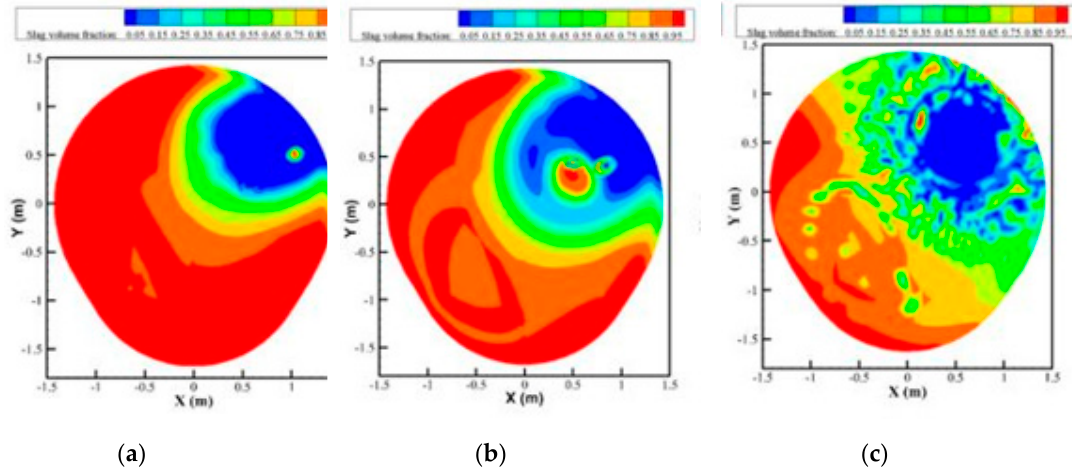
Figure 13. Open-eye size in the ladle from simulation results for a slag layer thickness of 25 cm: ( a ) Q = 200 NL/min, ( b ) Q = 400 NL/min, and ( c ) Q = 500 NL/min.